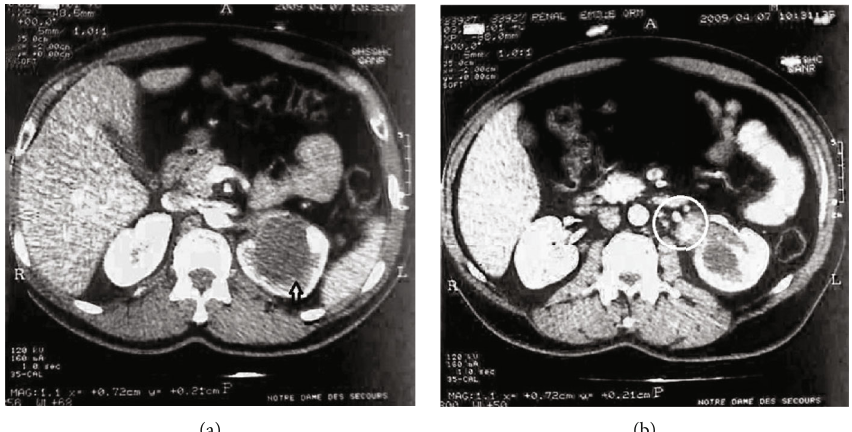
Figure 1: CT scan of the patient showing a 5 cm solid mass of the left renal pelvis (a, arrow) and multiple infracentimetric perihilar lymph nodes (b, circle).